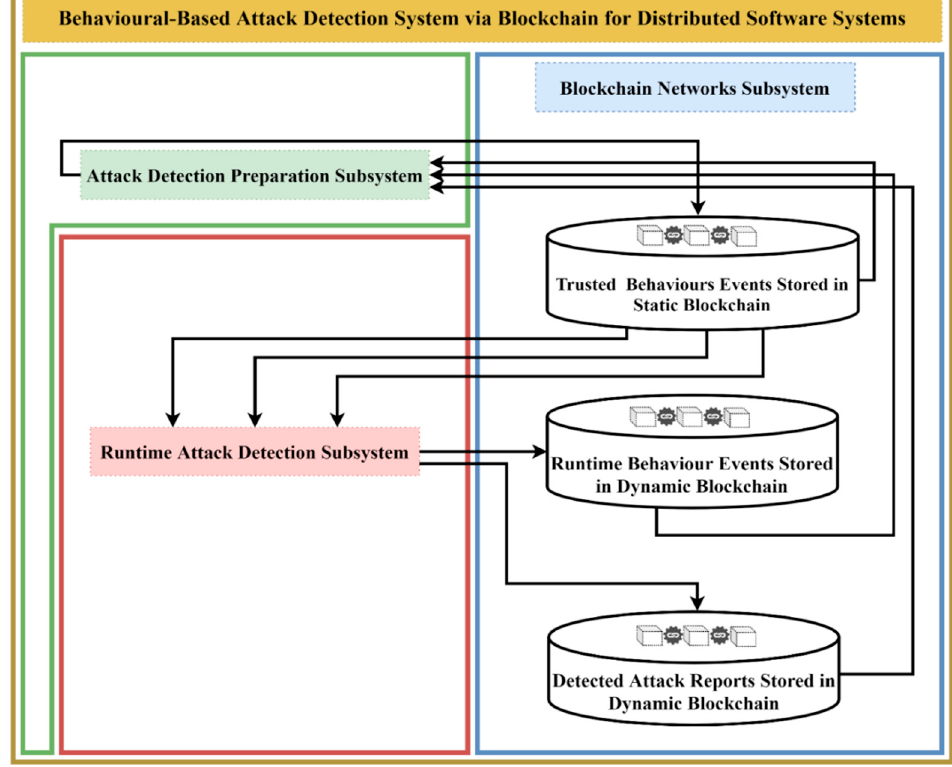
Figure 6. Software system architecture for Blockchain Networks (BNs) Subsystem.